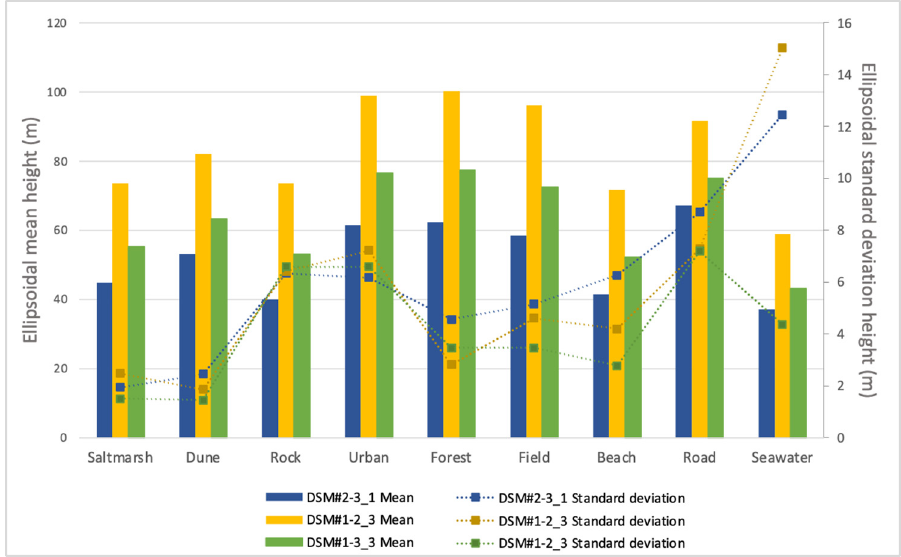
Figure 8. Ellipsoidal mean and standard deviation height at the class level on the sub–study site from the three best digital surface models.